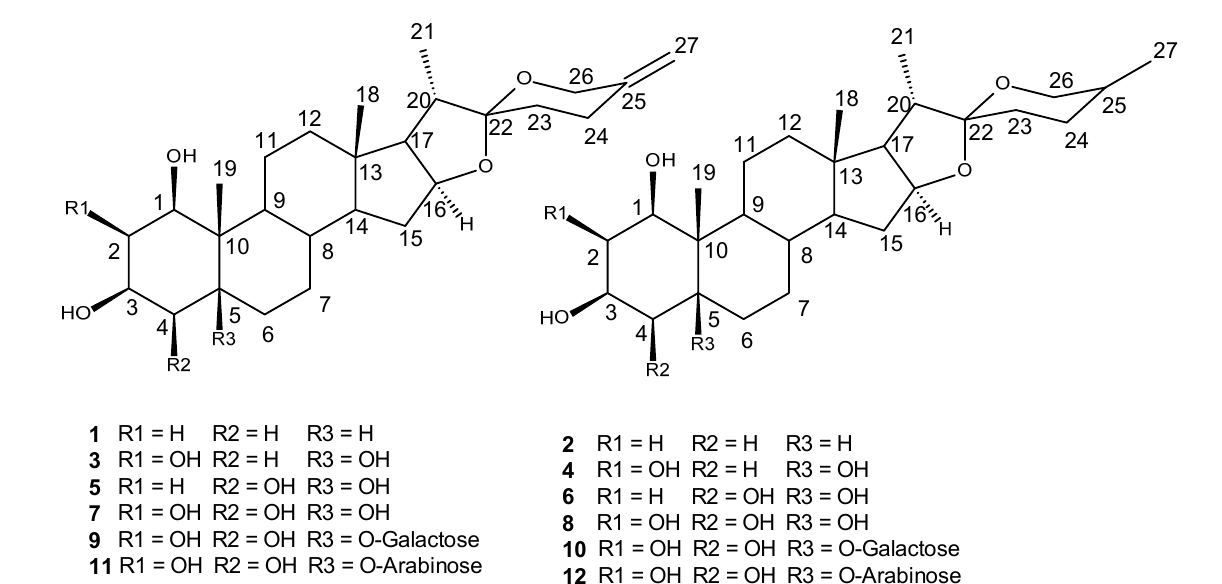
Figure 1. Structures of sapogenins and saponins isolated from Convallaria majalis described in the present study with carbon numeration.